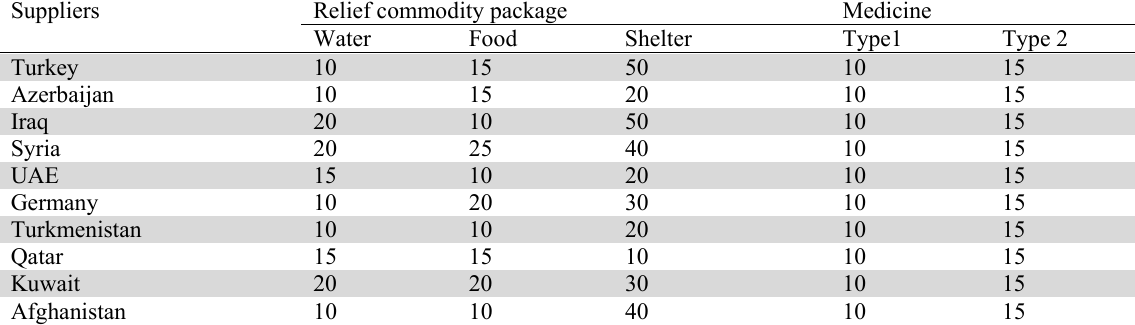
Foreign suppliers’ available package of aid commodities for each period Suppliers Relief commodity package Medicine